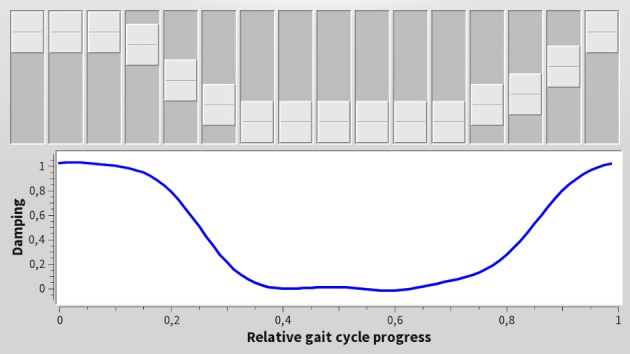
User interface to tune the control output, i.e., the knee damping. The horizontal axis shows the gait phase φ, the vertical the desired damping c. Changing a slider, directly modifies the desired damping at the corresponding gait phase. The system updates its behavior immediately to changed user input. This enables users to tune the device's behavior to their expectations and needs.